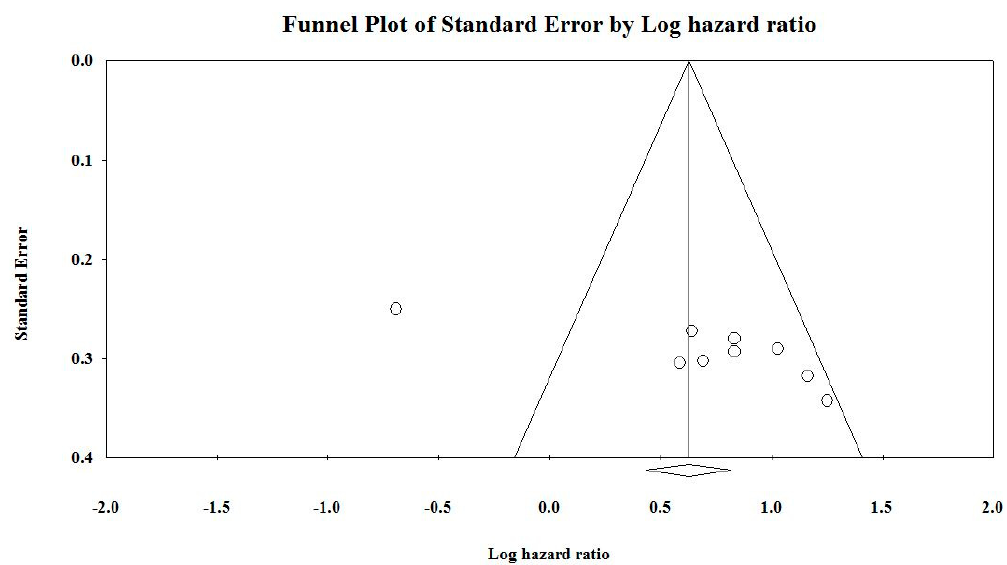
Figure 5. Funnel plot of studies included in the meta-analysis. Each study is represented as clear circles, and the studies outside the line represent the asymmetry.